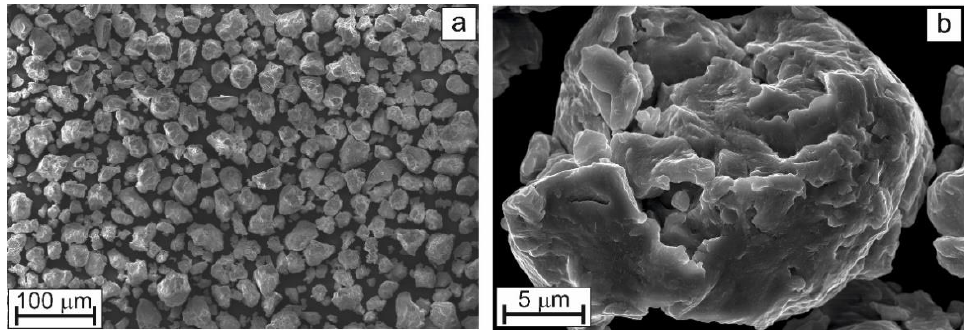
Figure 1. External views of mechanically alloyed powder after 90 min of high-energy ball milling, ( a ) general view; ( b ) single particle.